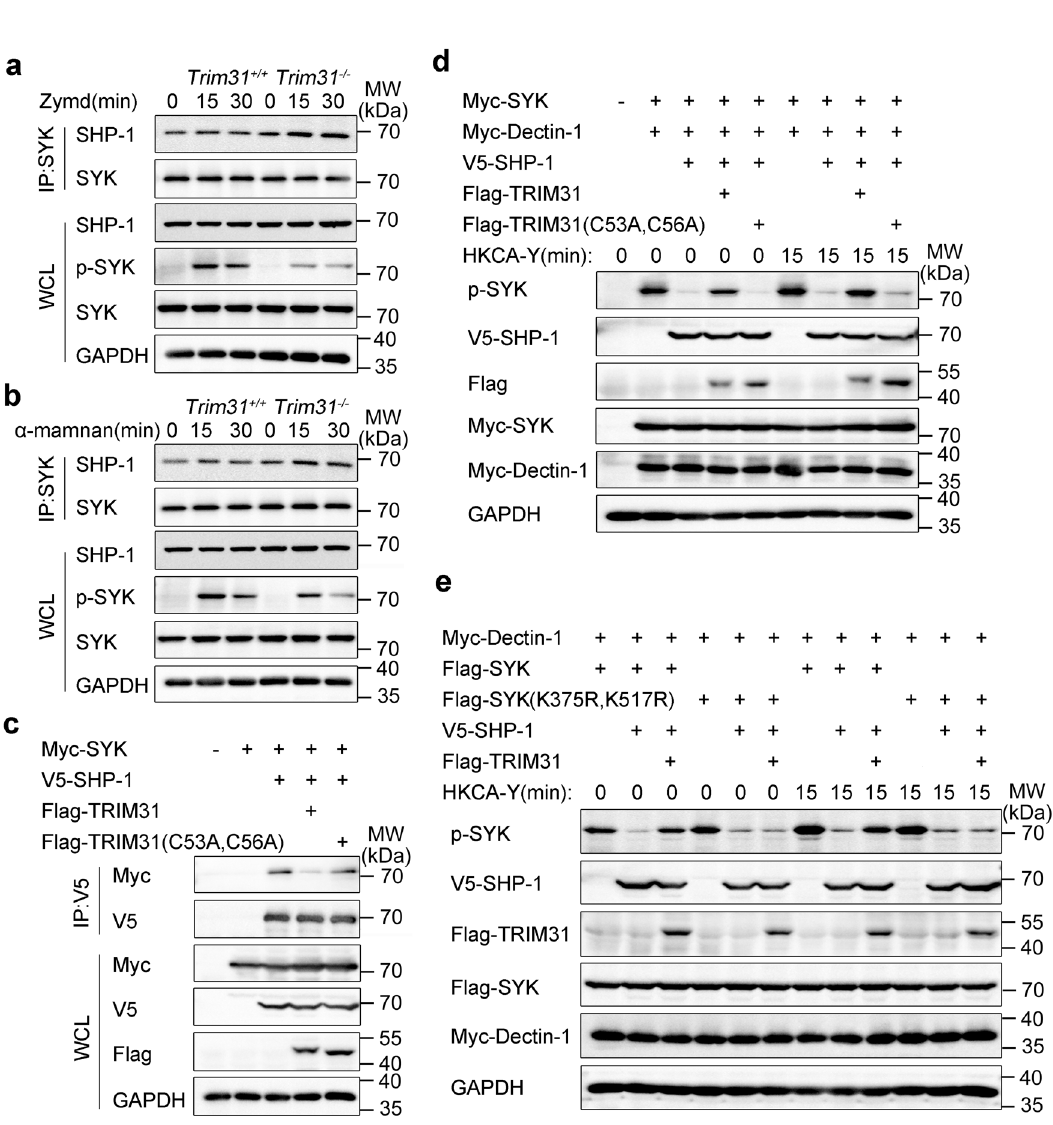
Fig. 7 TRIM31 inhibits SHP-1 regulation SYK activation. a, b Trim31 + / + and Trim31 − / − BMDCs uninfected (0 min) or infected Zymd ( a ) or α - mannan ( b ) for 15 min and 30 min, followed by IP with anti-SYK, probed with anti-SHP-1, WCL immunoblot analysis with indicated antibodies (left margins). c HEK293T cells were transfected with Myc-SYK, V5-SHP-1 and Flag-TRIM31, or Flag-TRIM31 (C53A, C56A). Followed by IP with anti-V5, probed with indicated antibodies (left margins). d HEK293T cells were transfected with Myc-SYK, Myc-Dectin-1, V5-SHP-1, Flag- TRIM31, or Flag-TRIM31 (C53A, C56A) by various combinations, cells were unstimulated or stimulated with HKCA-Y (MOI, 2) for 15 min, WCL immunoblot analysis with indicated antibodies (left margins). e HEK293T cells transfected by various combinations of plasmids expressing Flag-SYK, Flag-SYK (K375R, K517R), Myc-Dectin-1, V5-SHP-1, and Flag-TRIM31, cells were unstimulated or stimulated by HKCA-Y (MOI, 2) for 15 min. WCL immunoblot analysis with indicated antibodies (left margins). Data are from one experiment representative of three independent experiments ( a – e